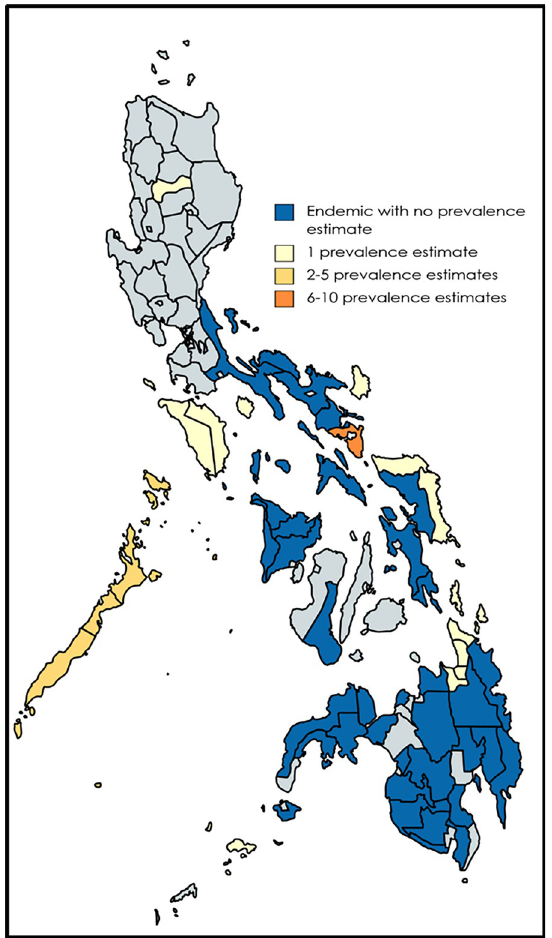
Fig 4. Sites of lymphatic filariasis prevalence estimates. Created using MapChart (https://mapchart.net/index.html.